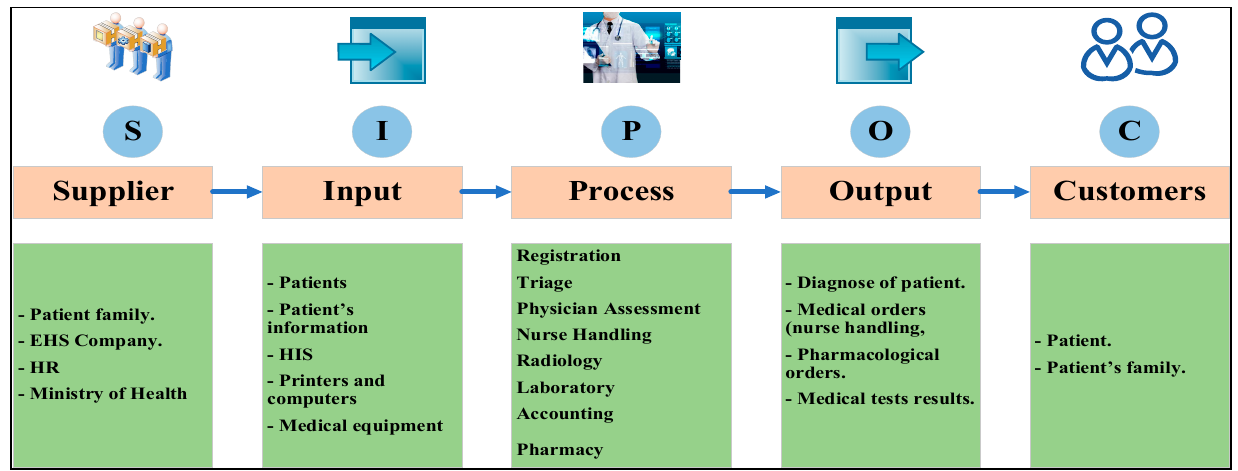
Figure 3. SIPOC Analysis.